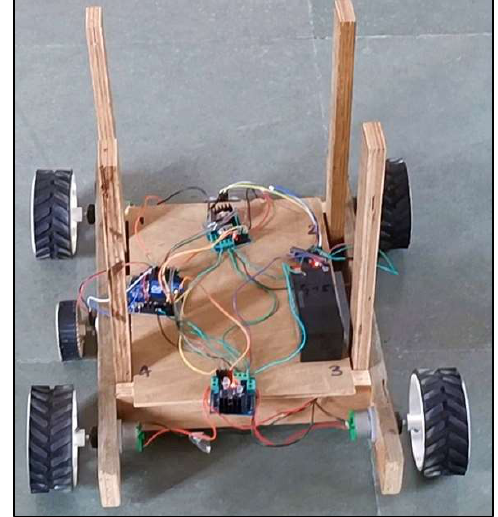
Fig. 13. Path Processing System Reading Fig. 8. Obstacle Avoidance System